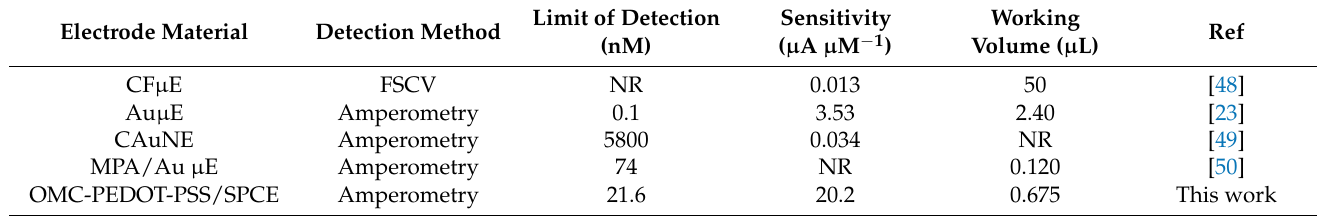
Table 1. A comparison of the performance of microfluidic based electrochemical sensors for dopamine